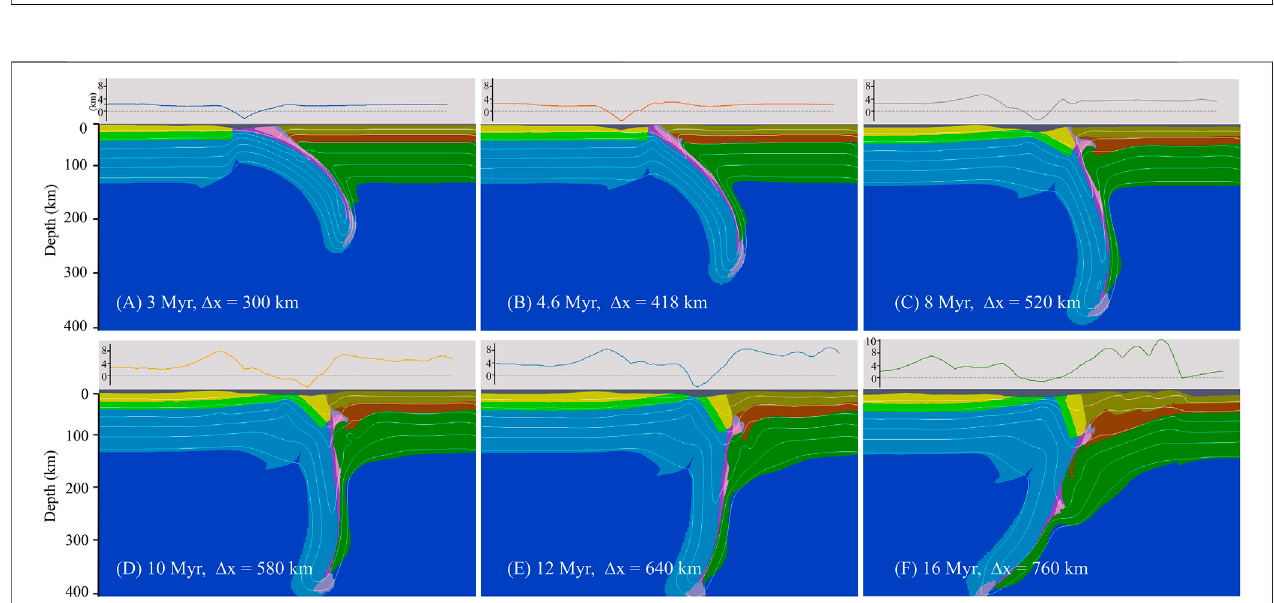
FIGURE7| Evolution oftheablative/two-sided continentalcollisionmode. Panels above each snapshot withgray shading show thecorrespondingtopography. Δ x is the amount of convergence. Different colors in (A – F) denote different lithologies (same as Figure 2 ).